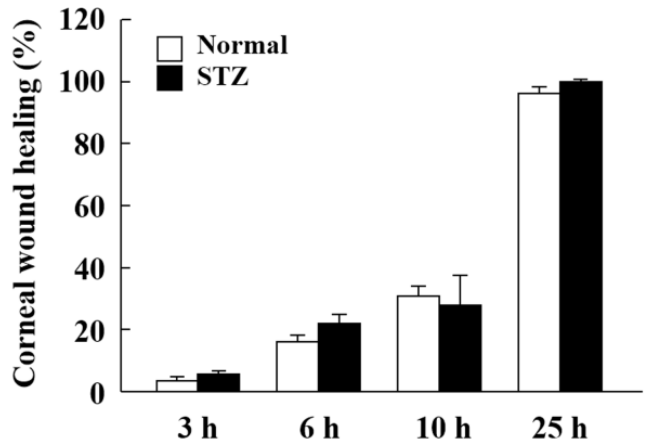
Figure 5. The corneal wound healing of normal and STZ rats after corneal epithelial abrasion. The corneal wound healing values (%) were calculated according to Equation 3. The data are presented as means ± S.E. of 5–10 rats.